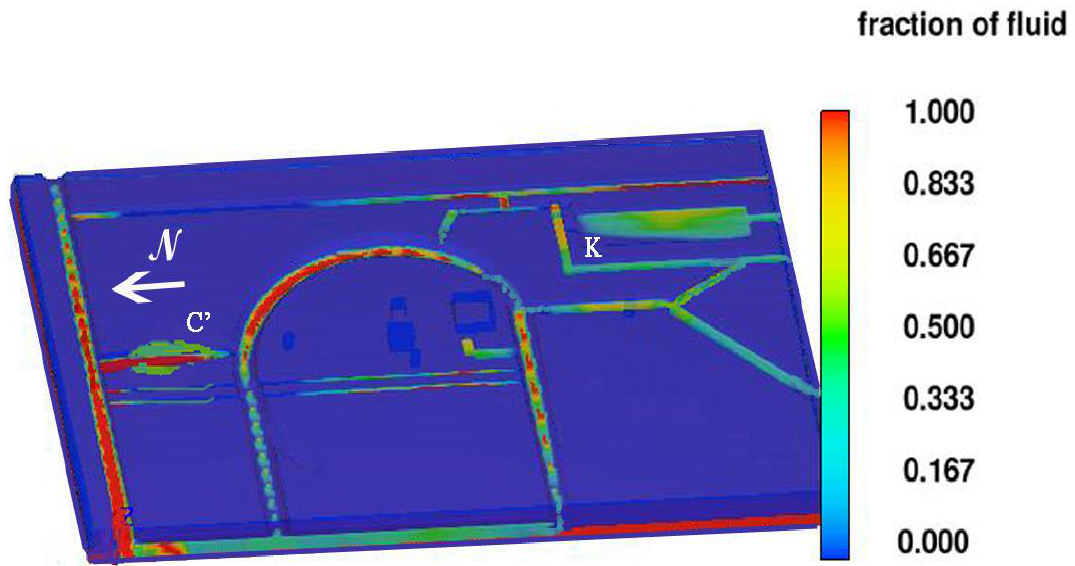
Figure 53. CFD fluid fraction results during the height of the dry season shown at the depth of subterranean channels P and Q; from [2], p. 180.